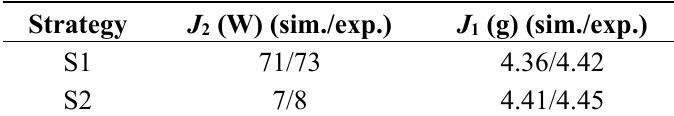
Table 2. Comparison between simulation and experiment in terms of the performance indices J 1 and J 2 . sim. = simulation, exp. =